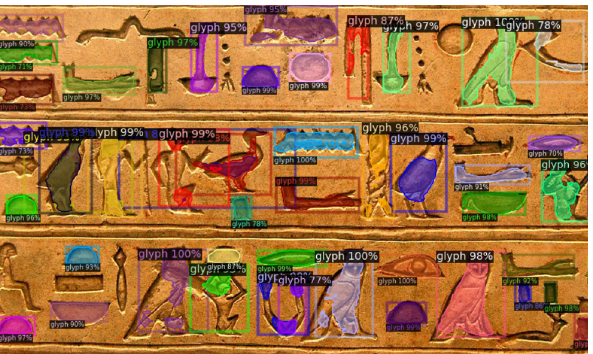
Figure 7. Segmentation results obtained with a training from scratch of 3000 epochs and with an objectness score threshold equal to 0.7.